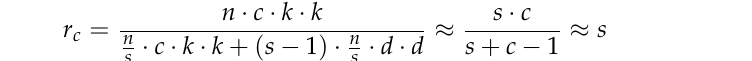
Figure 4. Detection algorithm structural diagram.